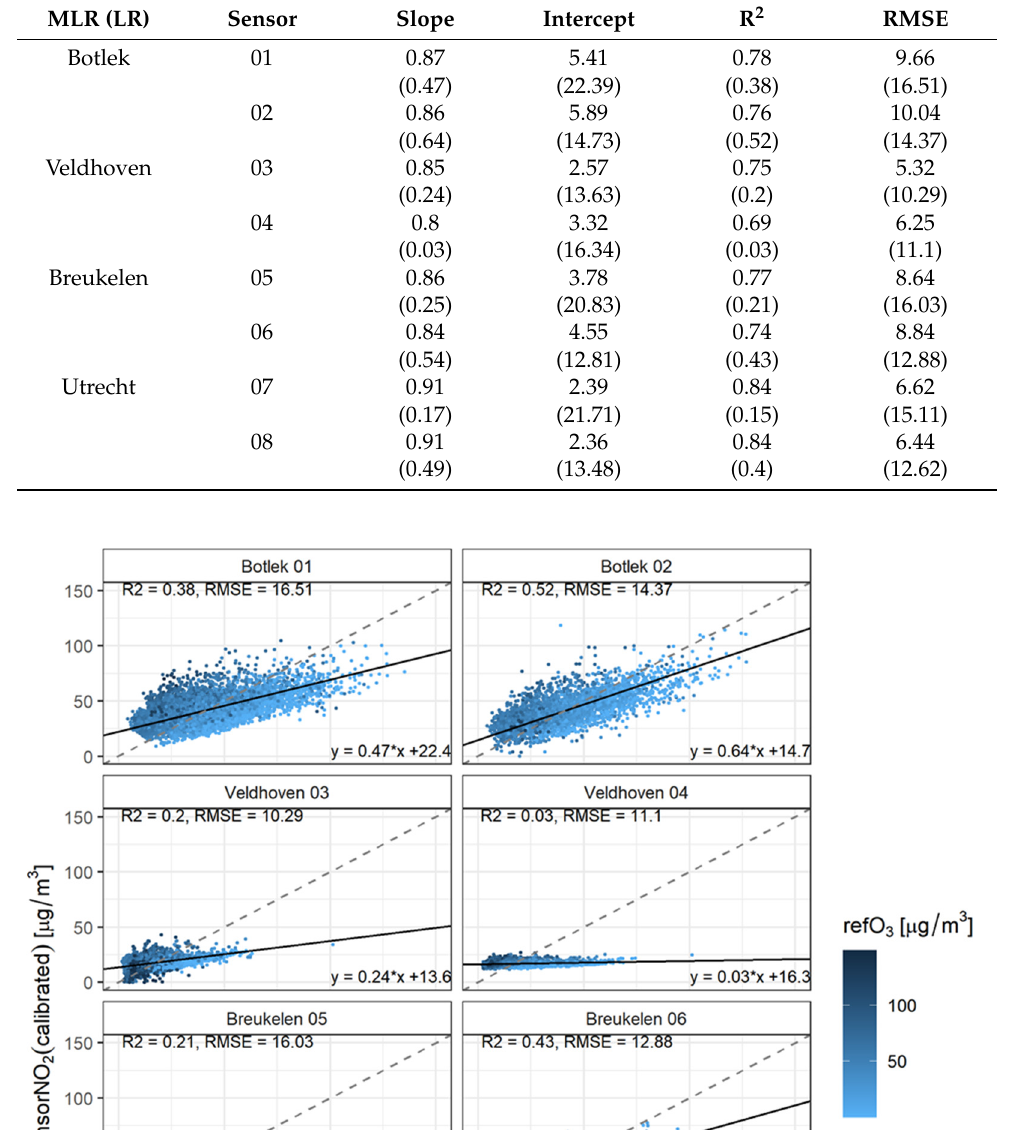
Table 2. Calibration performance expressed in R 2 , RMSE, slope and intercept. Numbers in parenthe- ses are the results from single linear regression.